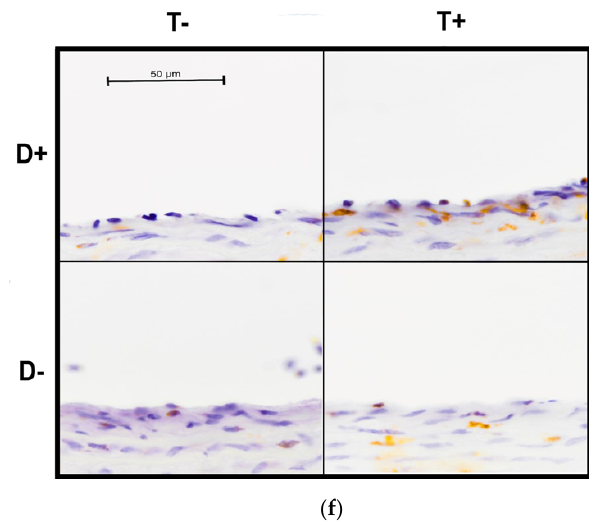
Figure 3. Immunohistochemical changes in thoracic aorta wall. Panel ( a ) . Immunohistochemical staining of the aortic wall with ER α antibody. Non-calibrated optical density was measured. Vitamin D deficiency significantly decreased while testosterone treatment increased ER α specific staining. T-D- group had significantly lighter staining compared to all other experimental groups. Panel ( b ) shows representative images of ER α staining. Specific staining is visualized by brown- colored DAB, while blue-colored hematoxylin serves as counterstaining. Data are presented as mean ± SEM. Two-way (testosterone treatment and vitamin D status) ANOVA; Tukey’s post-hoc test, **: p < 0.01 T-D+ vs. T-D+ group, ˆˆˆ: p < 0.005 T-D+ vs. T+D+ group, łł: p < 0.01 T-D- vs. T+D- group; tt: p < 0.01 T- vs. T+, dd: p < 0.01 D+ vs. D-. N = 5–6 in each group. Panel ( c ). Immunohistochemical staining of the aortic wall with eNOS antibody. Vitamin D deficiency significantly decreased eNOS specific staining while testosterone treatment did not alter immunostaining. Panel ( d ) are representative images of eNOS staining. Data are presented as mean ± SEM. Two-way (testosterone treatment and vitamin D status) ANOVA; d: p < 0.05 D+ vs. D-. N = 4–6 in each group. Panel ( e ) Immunohistochemical staining of the aortic wall with COX-2 antibody. Percentage is calculated by comparing the positively stained area to total tissue area. Testosterone treatment significantly increased COX-2 staining in our experiment. D+T- group had significantly larger area stained compared to control. Panel ( f ) shows COX-2 staining in the different groups. Data are presented as mean ± SEM. Two-way (testosterone treatment and vitamin D status) ANOVA; Tukey’s post hoc test, $: p < 0.05 T-D+ vs. T+D+ group, d: p < 0,05 D+ vs. D-. N = 4–5 in each group .